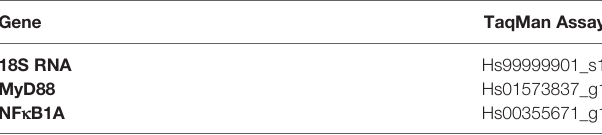
TABLE 1 | TaqMan Gene Expression Assays (Life Technologies) used for RT